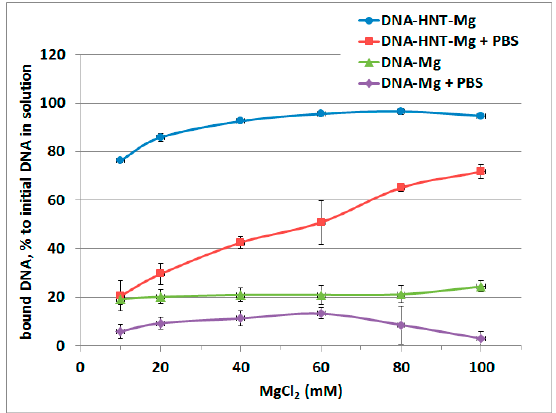
Figure 5. The amount of DNA bound to halloysite after initial incubation with different concentrations of MgCl 2 followed by incubation in PBS solution.